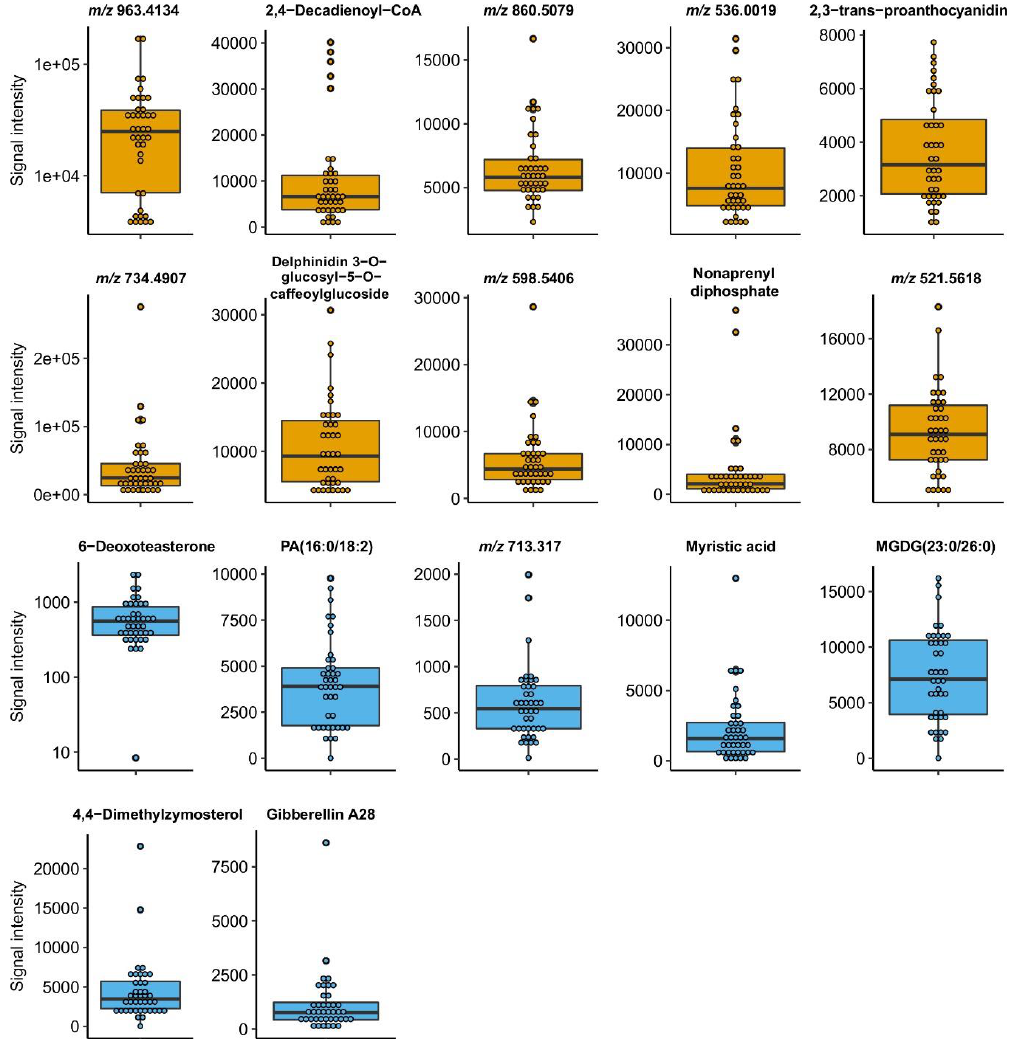
Figure 7. Distribution of abundances of top metabolites in parent C. canephora plant tissues. Level distribution across the 40 C. canephora parent plants are depicted for the metabolites listed in Table 3. Yellow-colored boxplots indicate metabolites found in fruits and blue color represents metabolites from the coffee leaf.